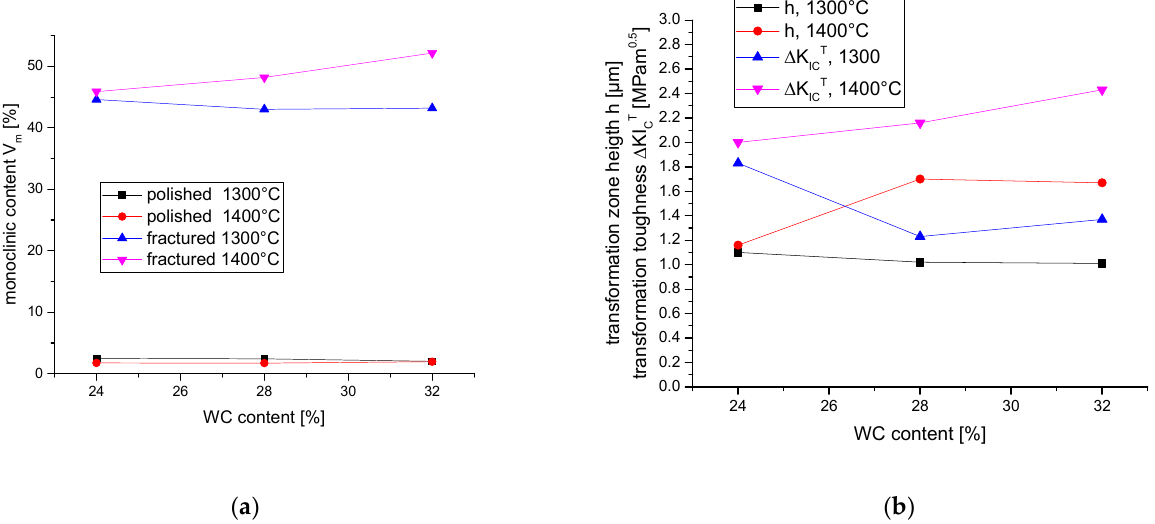
Figure 4. Monoclinic contents calculated from X-Ray diffraction data and calculated transformation characteristics. ( a ) Monoclinic contents of polished surfaces and fracture faces of TZP-WC materials sintered at 1300 °C and 1400 °C. ( b ) Calculated transformation zone height h and transformation toughness increment ΔK ICT .